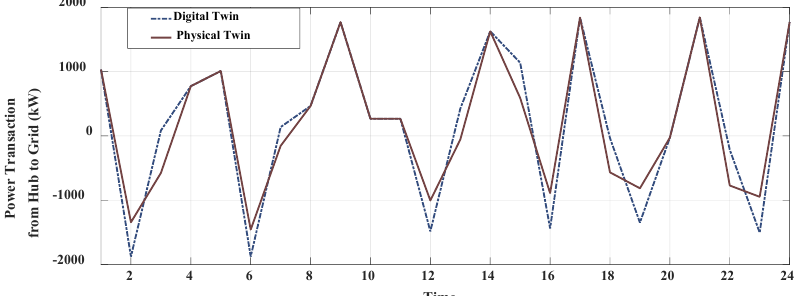
Figure 11. The power transaction for the physical and digital twins.